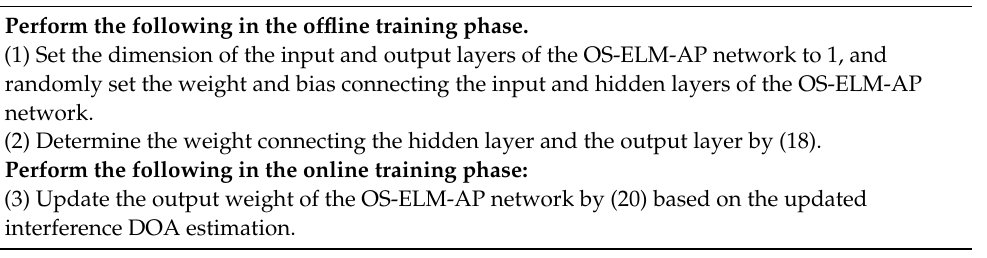
Algorithm 2 OS-ELM-AP-based interference angle prediction